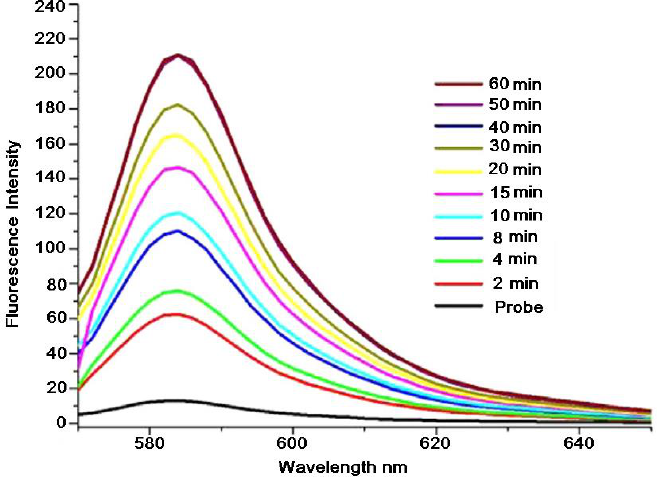
Figure 3. Time-dependent fluorescence response of VRF probe (10 μ M) with Hg 2+ (100 μ M) in CH 3 CN/HEPES buffer (1:1, 0.1 M, pH = 7.4) at 25 °C; excitation wavelength = 560 nm, emission wavelength = 585 nm. The reaction was completed within one hour.